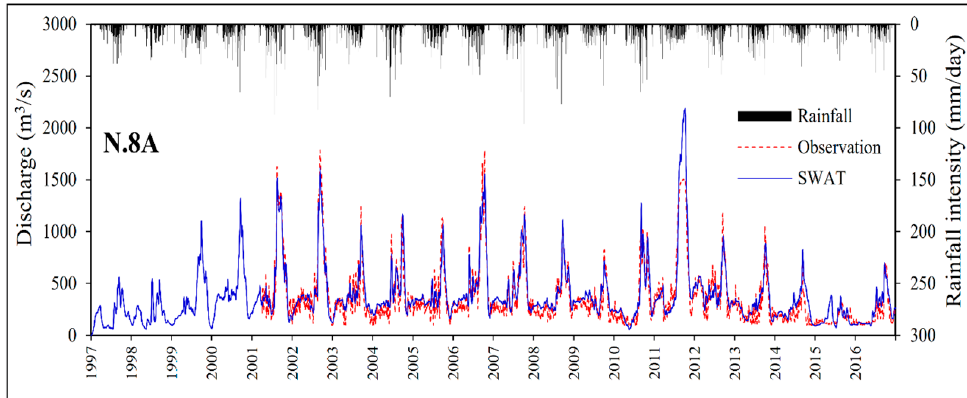
Figure 3. Comparison of daily river discharge from simulation and observation at station N.8A.